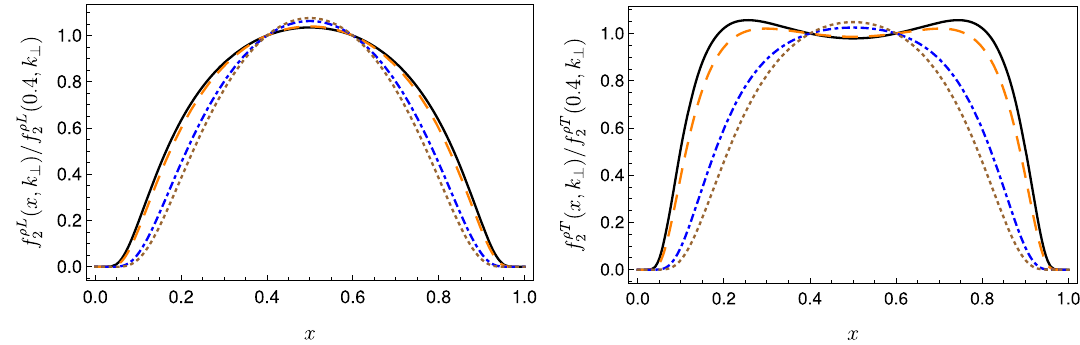
Fig. 17 Same of Fig. 5 for the ρ meson. Left panel for longitudinal polarisation. Right panel for transverse polarisation